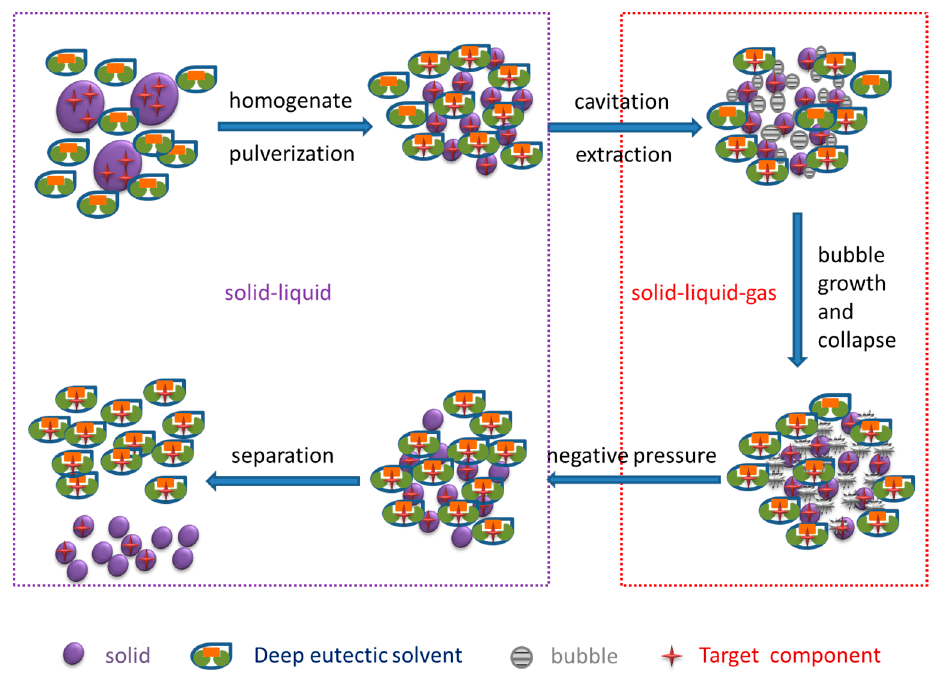
Figure 7. Schematic diagram of homogenate-assisted vacuum-cavitation effect.